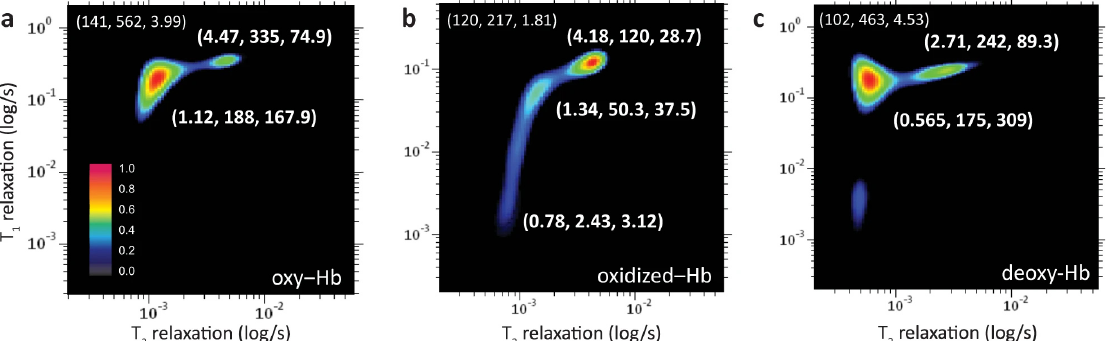
Figure 26. T 1 –T 2 correlational maps in false colors of red blood cells at different conditions: oxy- genated ( a ), oxidized ( b ), and deoxygenated ( c ). Figure reprinted from Ref. [130] under the terms